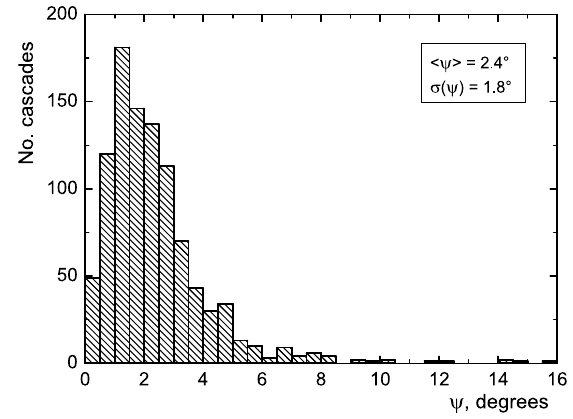
Figure 4. Distribution of cascades of the etalon sample in the spatial angle between the reconstructed cascade axes and the muon track measured by means of DECOR.